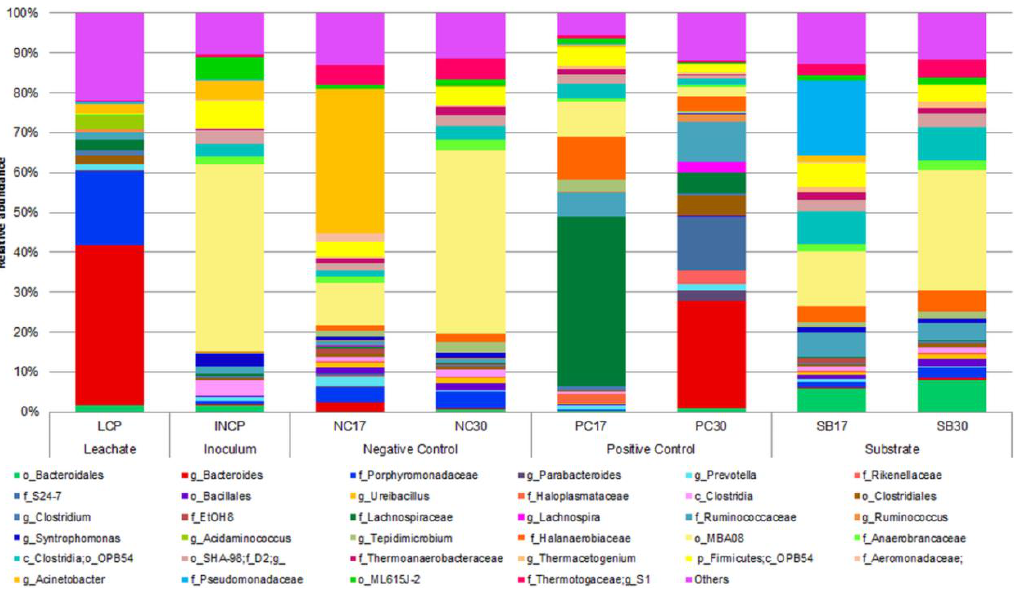
Figure 3. Relative abundance (%) of different levels of bacterial taxa in the leachate (LCP), inoculum (INCP), and treatment groups (NC — negative control; PC — positive control; SB — substrate; 17-on 17 days; 30-on 30 days).